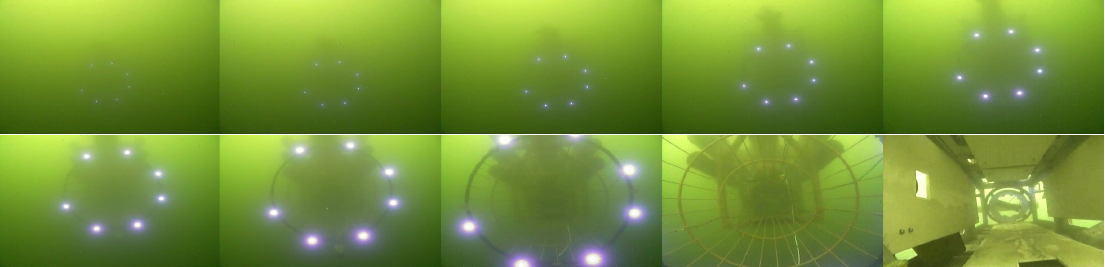
Figure 16. Images of the recycling process of Run